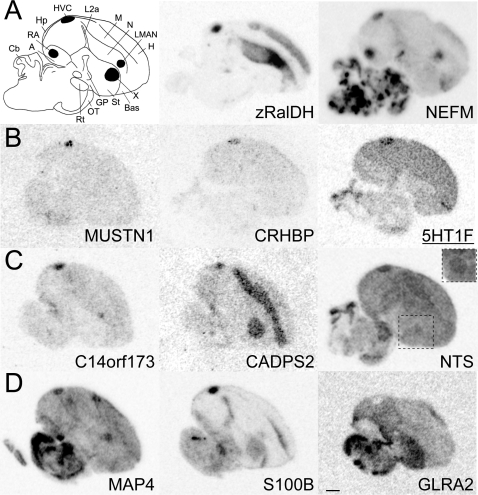
(A–D) Representative in situ hybridization autoradiograms of parasagittal sections of adult male zebra finches at the level of HVC (∼1.4 to 2.4 mm from the midline).(A, left) Schematic depicting the major telencephalic song nuclei (in black), thalamorecipient areas (i.e. L2a, Bas), and major brain subdivisions. (A, center and right) Expression of known HVC markers. The other panels (B–D) depict representative autoradiograms of HVC markers that are exclusive to HVC (B), enriched in HVC and other song nuclei, such as LMAN (C, left), or area X (C, center and right; inset shows area X from a more medial section), enriched in 3/4 major song nuclei (D, left and middle), or are negative markers (D, right). Notice that some markers are also enriched in distinct pallial and striatal areas, and/or primary sensory areas. Scalebar: 1 mm. Gene abbreviations in Table S1. Anatomical abbreviations: A, Arcopallium; Bas, nucleus basorostralis; Cb, Cerebellum; GP, globus pallidus; Hp; Hippocampus; H, Hyperpallium; L2a, subfield L2a of field L; LMAN, lateral magnocellular nucleus of the anterior nidopallium; M, Mesopallium; N, Nidopallium; RA, robust nucleus of the arcopallium; Ot, optic tract; Rt, nucleus rotundus; St; striatum.